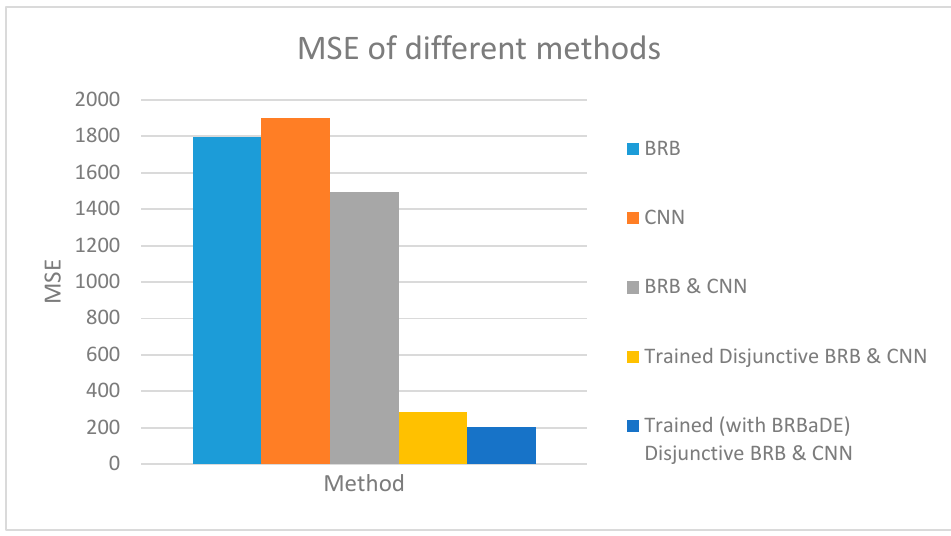
our proposed integrated approach (BRB and CNN).